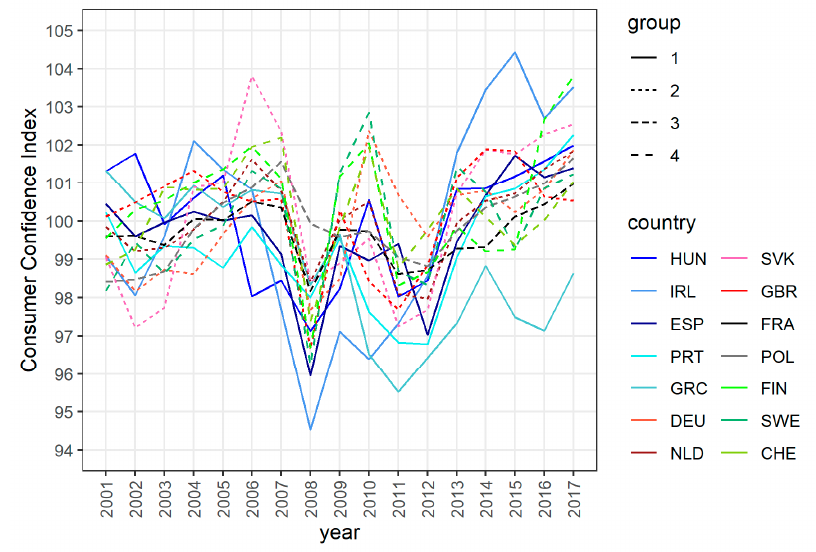
Figure 5. The development of the consumer confidence index in analyzed countries.